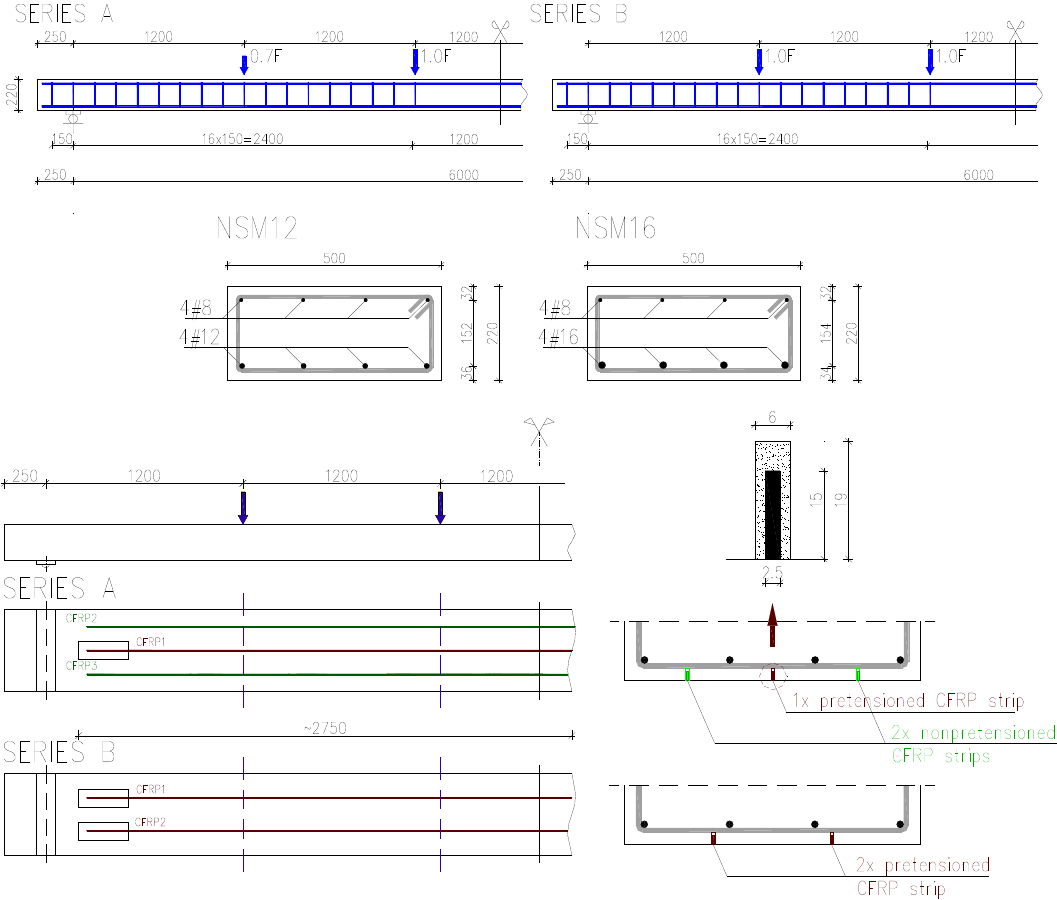
Figure 1. Static schemes, specimens’ cross-sections, and strengthening configurations.